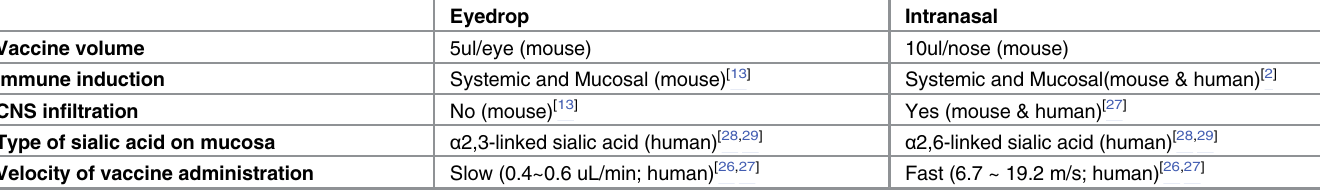
Table 2. The comparison of similarities or differences between EDV and IN